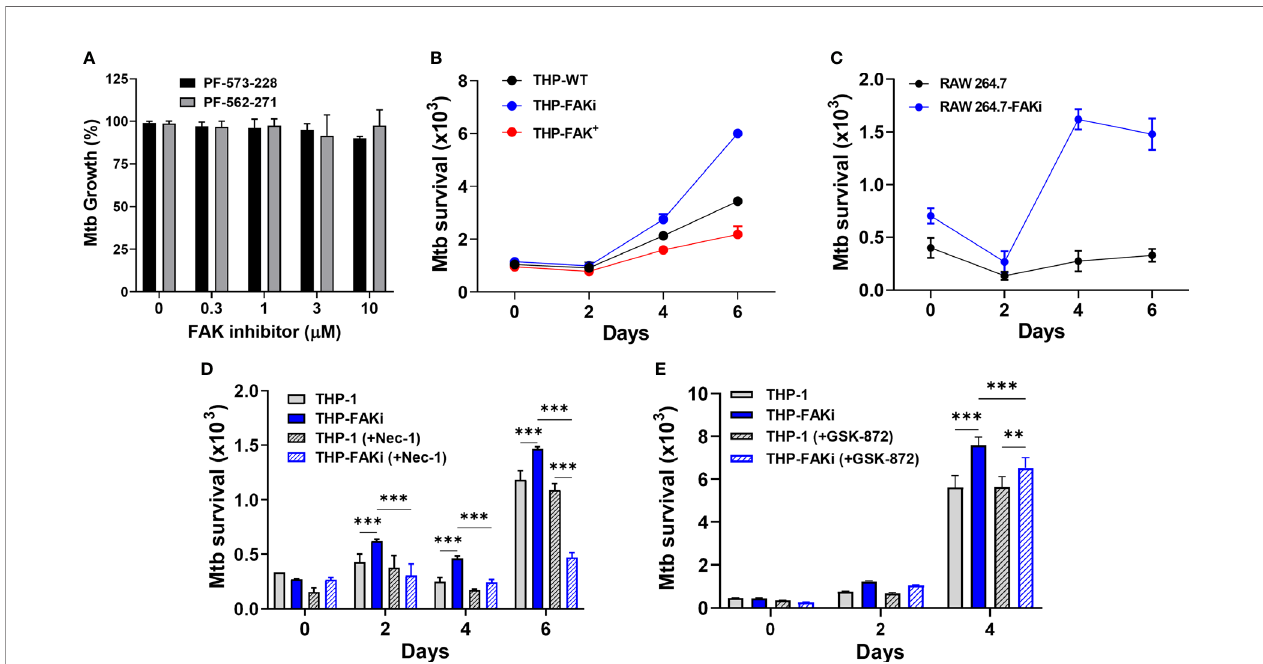
FIGURE 6 | Expression of FAK controls Mtb survival. (A) Mtb was treated with the indicated concentrations of FAK inhibitors (in the absence of macrophages), PF-573- 228 and PF-562-271, for 5 days, after which Mtb growth was assessed using the resazurin viability assay. Relative viability was normalized to 100% using untreated controls. (B) THP-1, THP-FAKi, and THP-FAK + macrophages, or (C) RAW 264.7 and RAW 264.7-FAKi macrophages were infected with Mtb-luciferase at an MOI of 10 for 6 days. Infected macrophages were lysed at the indicated time points post-infection and the resultant luminescence signal (RLU) was measured as a proxy for